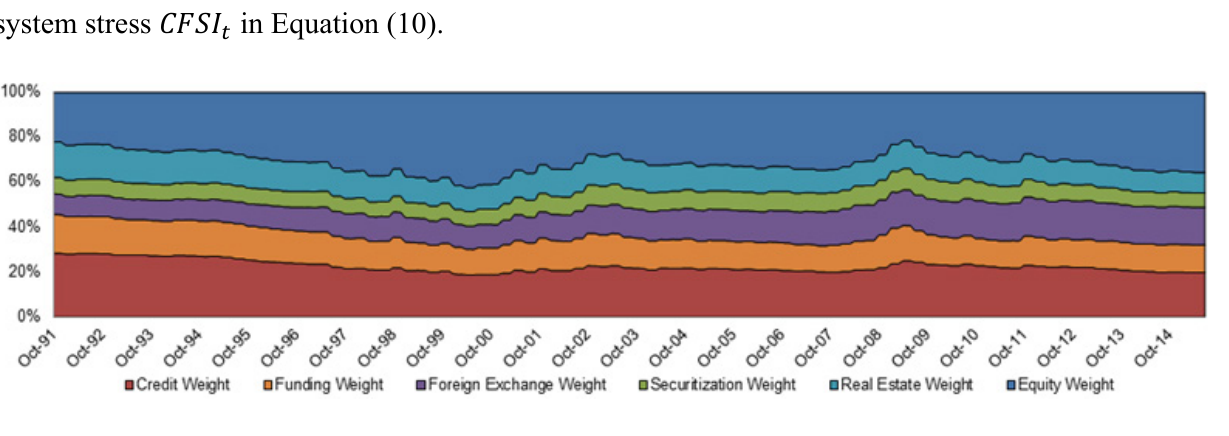
Figure 3. Credit weights used to calculate aggregate six-market